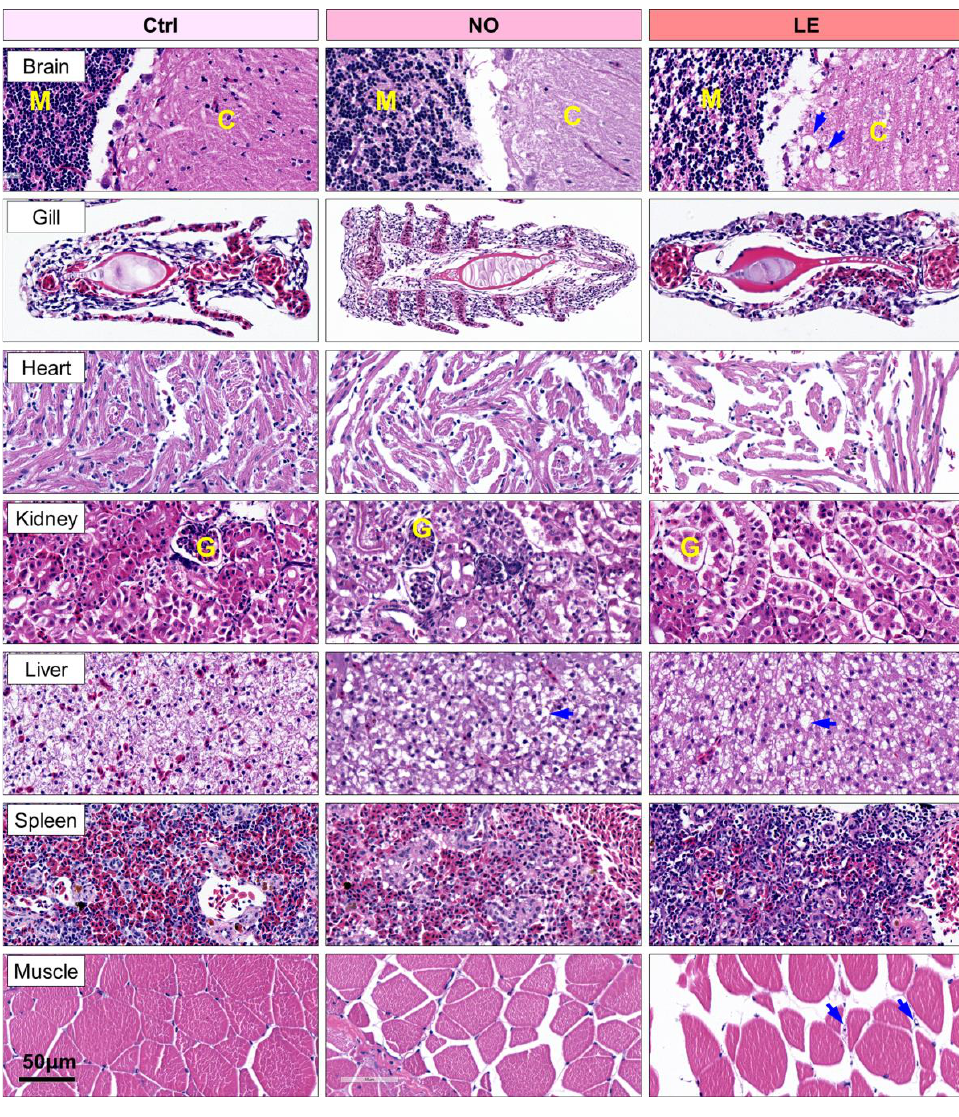
Figure 3. Exposure of Nile tilapia to lethal cold stress caused extensive tissue damage. After being held at 12 °C for 72 h, both the normal fish (NO, individuals that could swim normally at the sampling time) and those lost equilibrium (LE) were sampled. Ctrl indicates fish not exposed to cold stress. Sample numbers for the Ctrl, NO and LE groups are as follows: brain 1, 2, 2; gill 3, 4, 4; heart 3, 4, 4; kidney 1, 2, 2; liver 1, 2, 2; muscle 3, 4, 4; spleen 1, 2, 2. Representative photos are shown. The blue arrows in the brain and liver sections indicate vacuoles, while those in the muscle sections indicate necrotic fibers. M, medulla; C, cortex; F, gill filament; G, glomerulus. After cold exposure, the brain demonstrated obvious vacuoles (indicated by blue arrows) in both the medulla and cortex; nuclei density in medulla of both the NO and